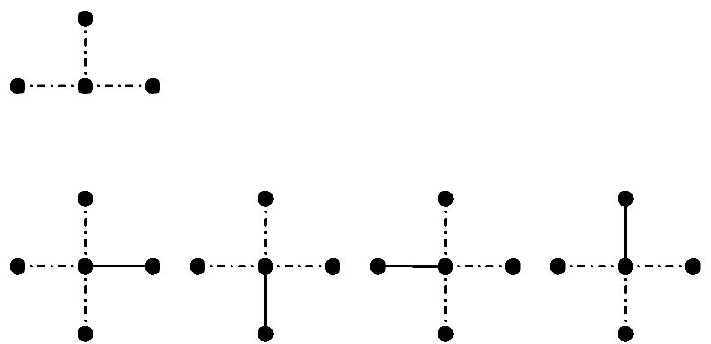
Figure 4. Number of ways of three bonds meeting at one lattice site up to a branching degree of four.